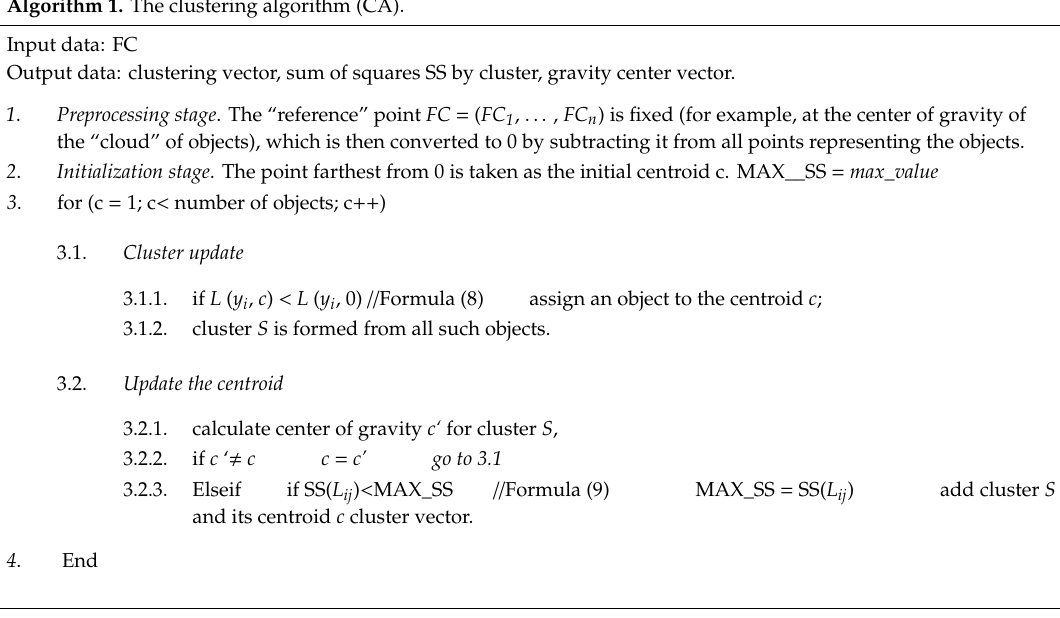
Algorithm 1. The clustering algorithm